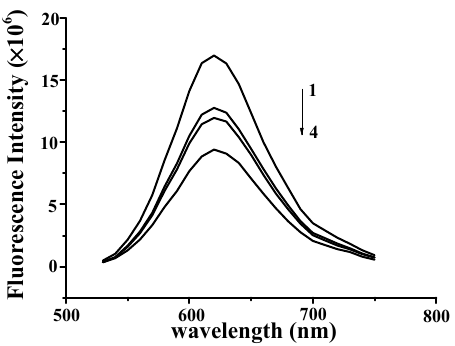
Figure 4. Fluorescence quenching spectra of DNA–YP–NR complexes ( C DNA = 0.9 mg/mL, C NR = 5 × 10 − 3 mg/mL) upon the addition of different YP concentrations: (1) 0 mg/mL, (2) 0.55 mg/mL, (3) 0.65 mg/mL, and (4) 0.75 mg/mL.